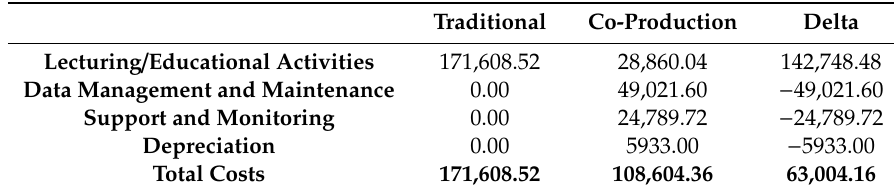
Table 7. Opportunity–cost analysis considering the depreciation costs.